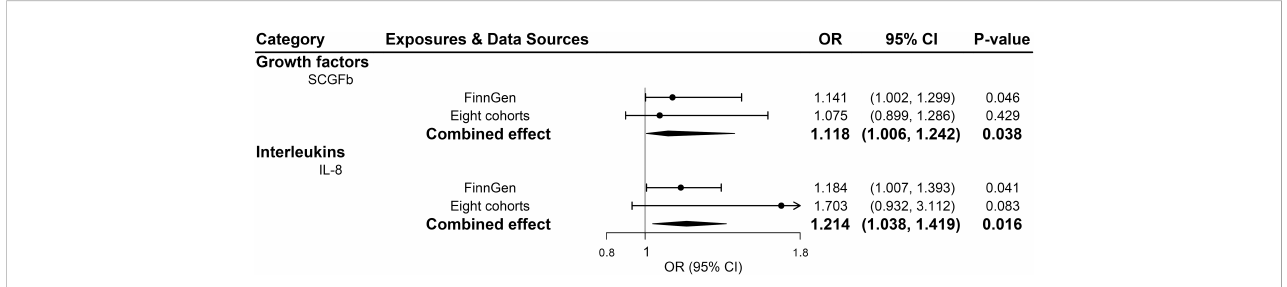
FIGURE 3 Signi fi cant associations between genetically predicted systemic in fl ammatory regulators and proliferative diabetic retinopathy (with SNPs reaching P <5×10 -6 ). IL, interleukin; SCGFb, stem cell growth factor beta.